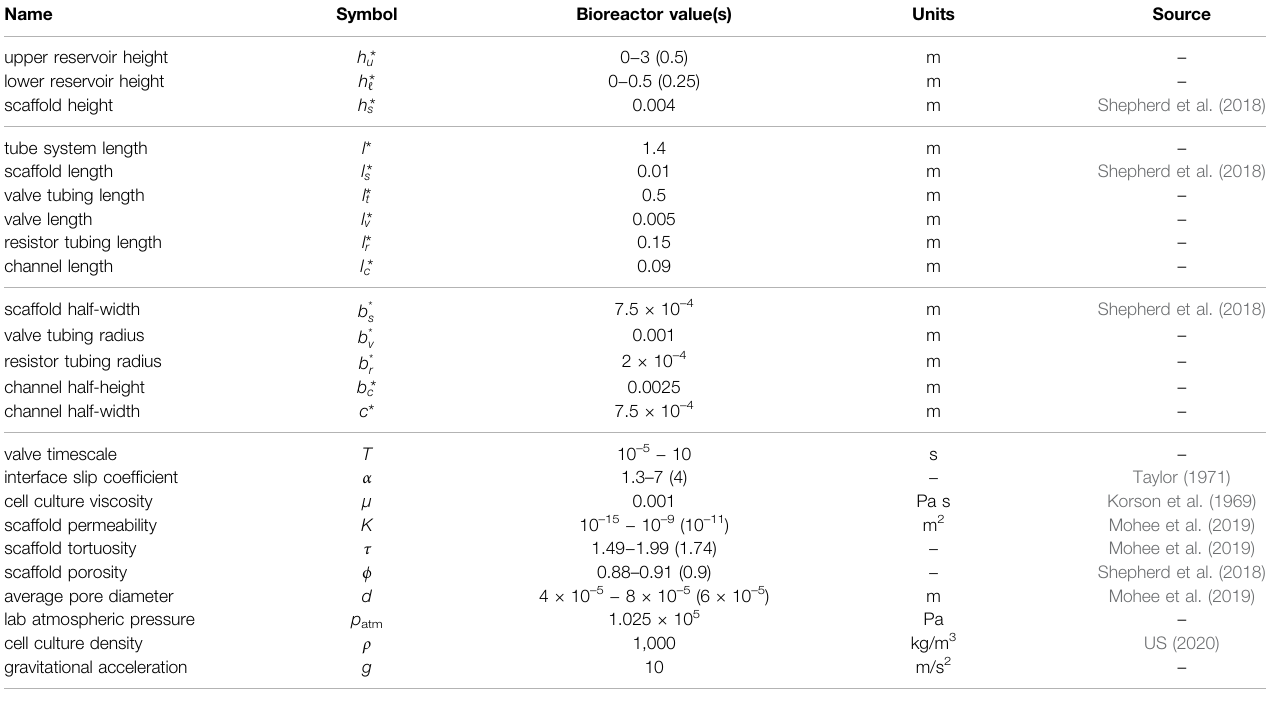
TABLE 1 | Model parameters, chosen to mimic the bioreactor of Shepherd et al. (2018). Where a range is give, values or ranges in brackets have been used in simulations. The values without a citation are reported here for the fi rst time.